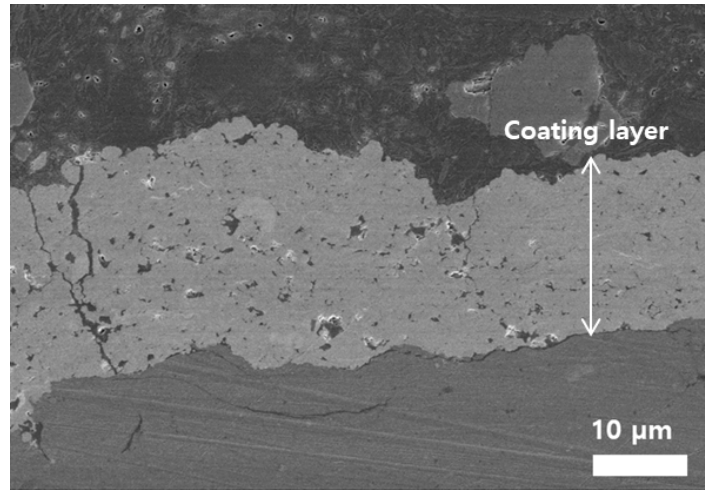
Figure 8. FE-SEM image of the cross-sectional microstructure of the YOF coating deposited with the severely flocculated Y 5 O 4 F 7 suspension without dispersant by the SPS process.